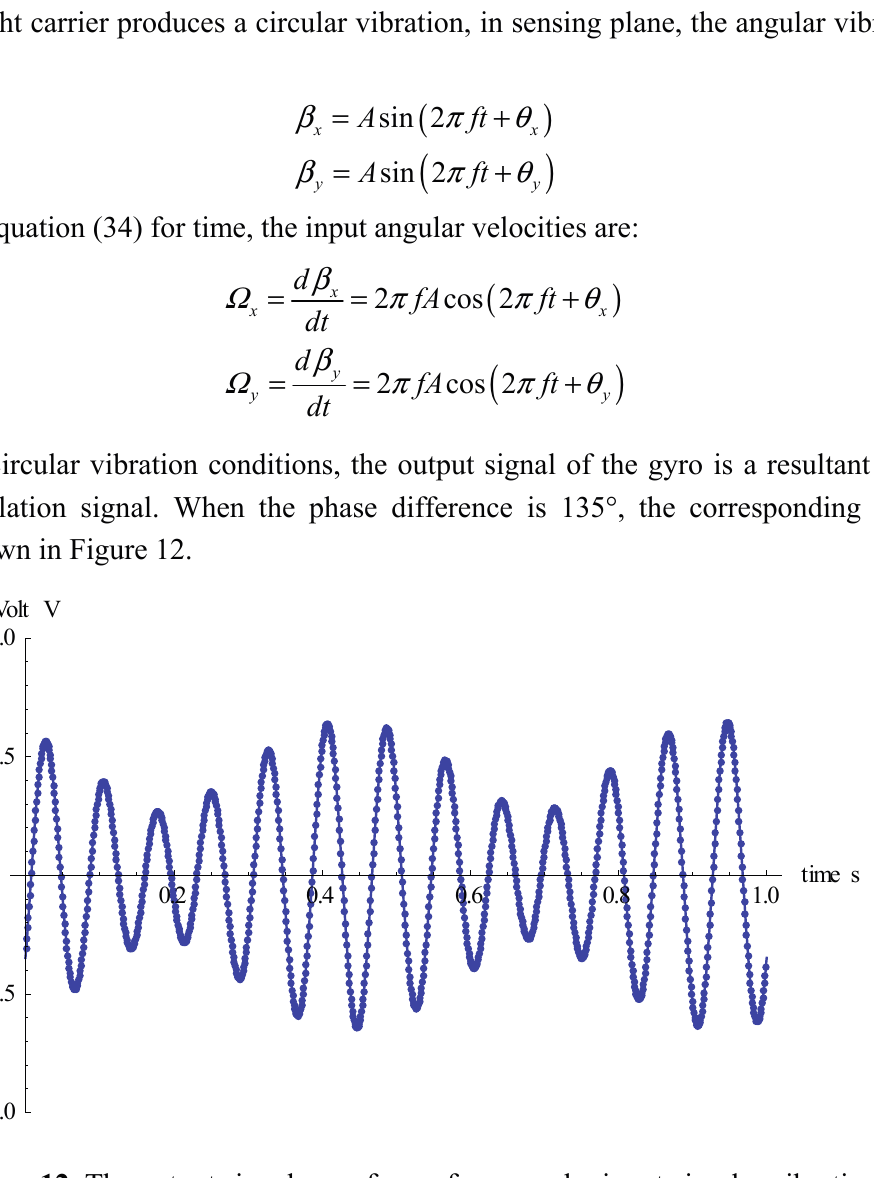
Figure 12. The output signal waveform of gyro under input circular